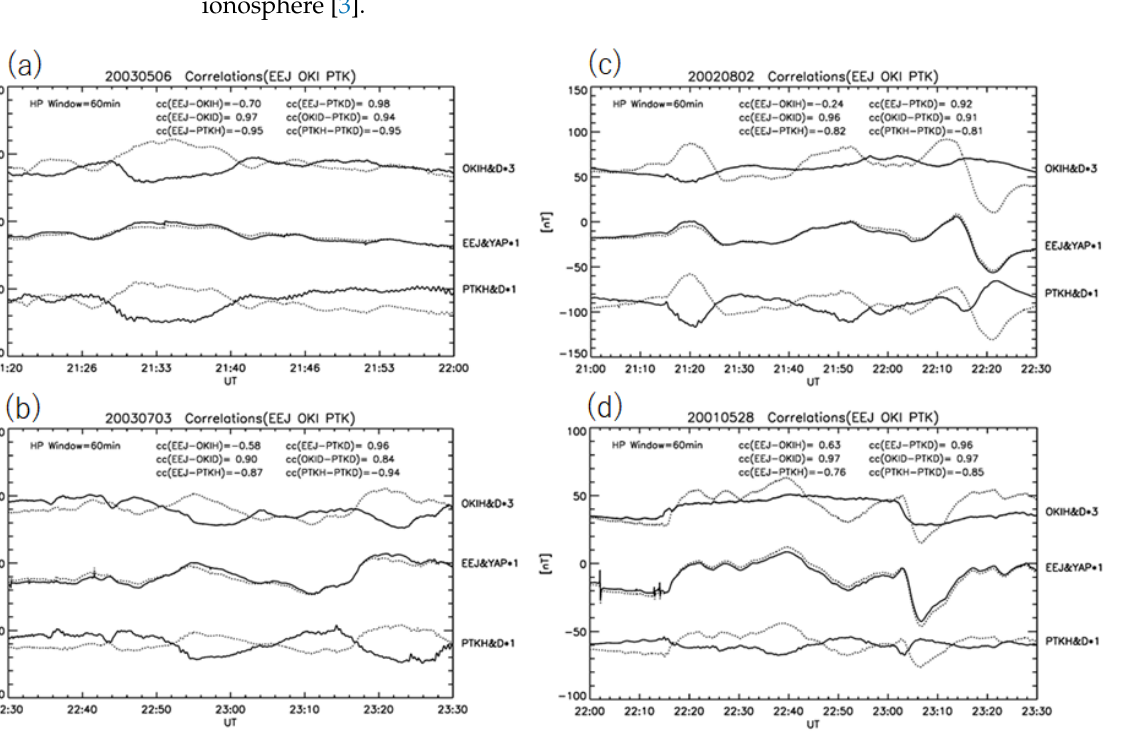
Figure 2. DP2 magnetic fluctuations recorded in H and D at PTK and OKI in the morning (0630-1030 MLT), denoted with PTKH (solid curve), PTKD (dotted curve), OKIH (solid curve), and OKID (dotted curve). OKIH and OKID are multiplied by three for better visibility. At the equator, EEJ (solid curve) and YAPH (dotted curve) are shown. The correlation coefficients between two variables are shown with cc in the frame. ( a – d ) are used for reference in the